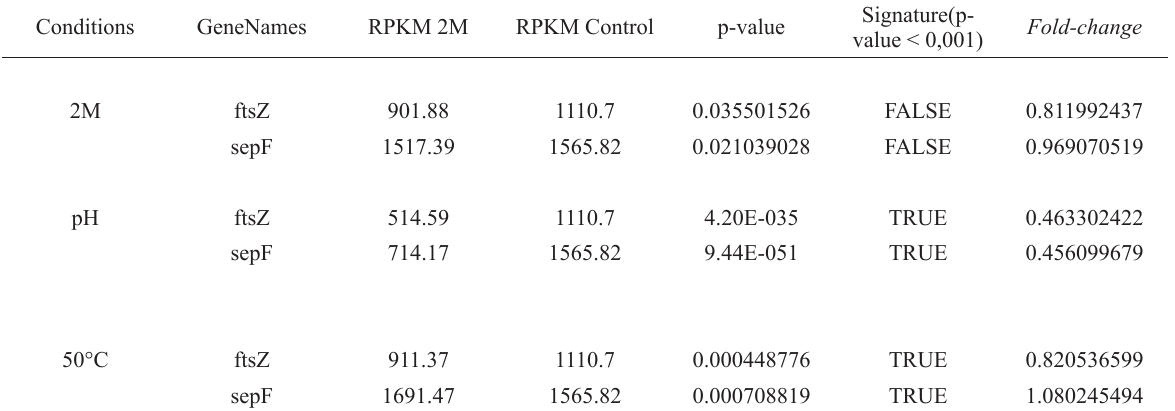
Information about the gene expression to FtsZ and